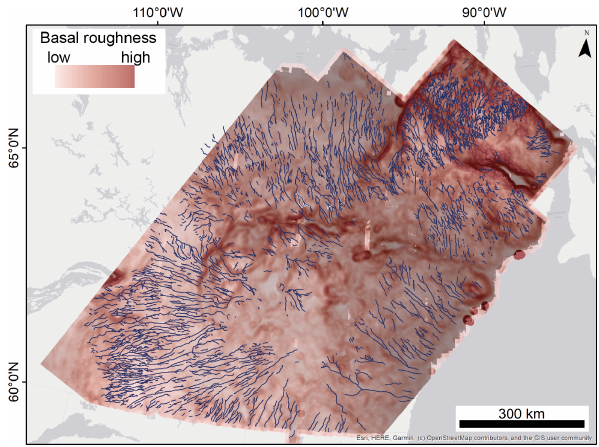
Figure 11. Meltwater routes overlain on local bed roughness cal- culated for the approximate wavelength expected to be relevant for the transfer of basal undulations to the ice surface. This is where the densest surface meltwater networks and ponding is likely to oc- cur given sufficient melt conditions (Ignéczi et al., 2018). © DEM created by the Polar Geospatial Center from DigitalGlobe, Inc. im-